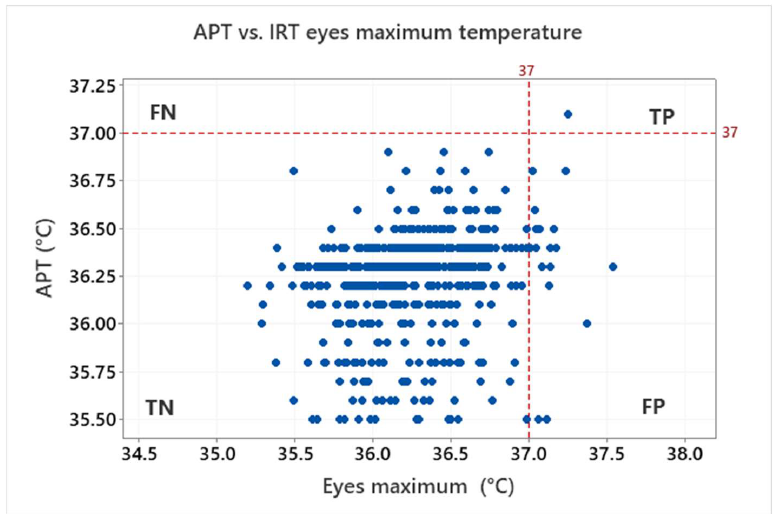
Figure 12. Graphical illustration of true positive (TP), true negative (TN), false positive (FP) and false negative (FN) for the IRT eyes maximum temperature in relation to the APT with the threshold 37 °C.